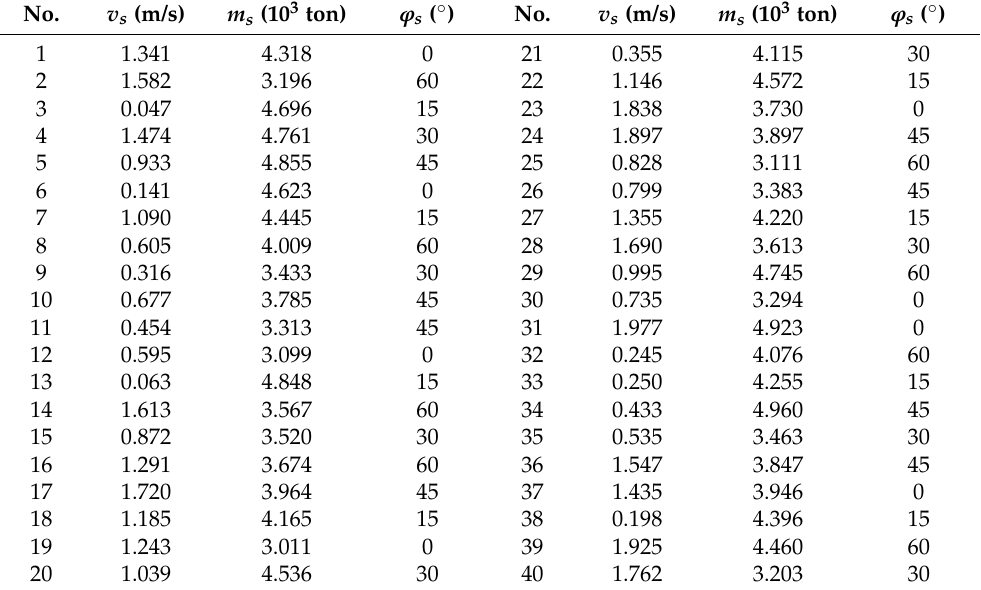
Table 2. 40 groups of collision scenarios for training selected via LHS sampling.